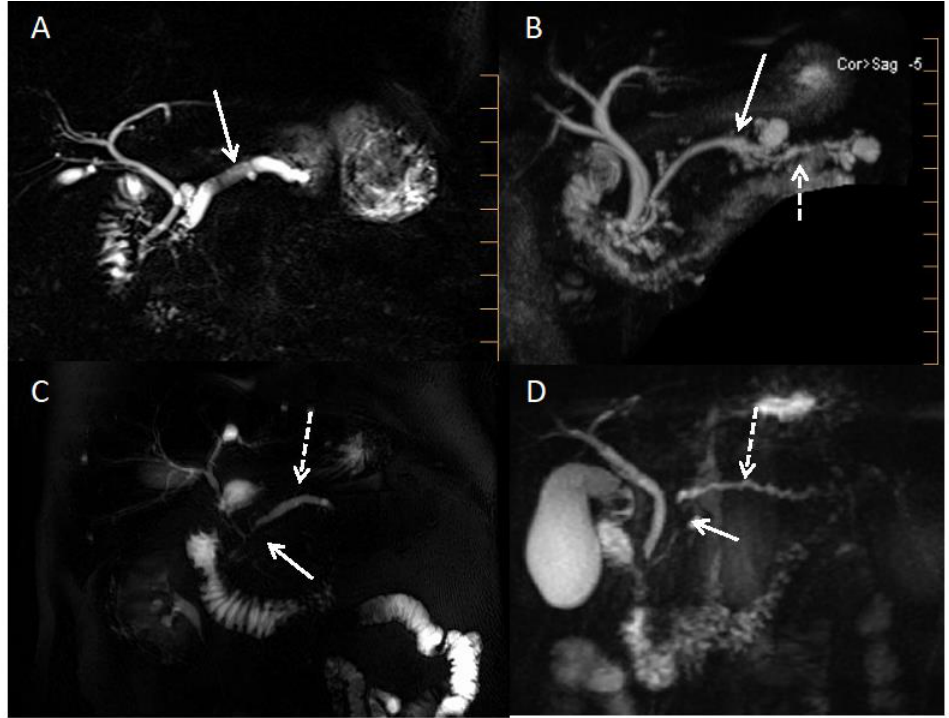
Figure 4. MRI cholangiopancreatography pictures of alcoholic chronic pancreatitis, pancreatic carcinoma, and obstructive chronic pancreatitis. ( A ): Alcoholic chronic pancreatitis with dilatated Wirsung duct and one or two pancreatic lithiasis (white arrow). ( B ): Mixed IPMN (white arrow) with upstream signs of obstructive chronic pancreatitis (dashed white arrow). ( C ): Pancreatic ductal adenocarcinoma (tumoral stenosis of the isthmus showed by the white arrow) with upstream regular Wirsung duct dilatation (dashed white arrow). ( D ): Pancreatic ductal adenocarcinoma (tumoral stenosis of the head showed by the white arrow) with upstream signs of obstructive chronic pancreatitis (dashed white arrow).